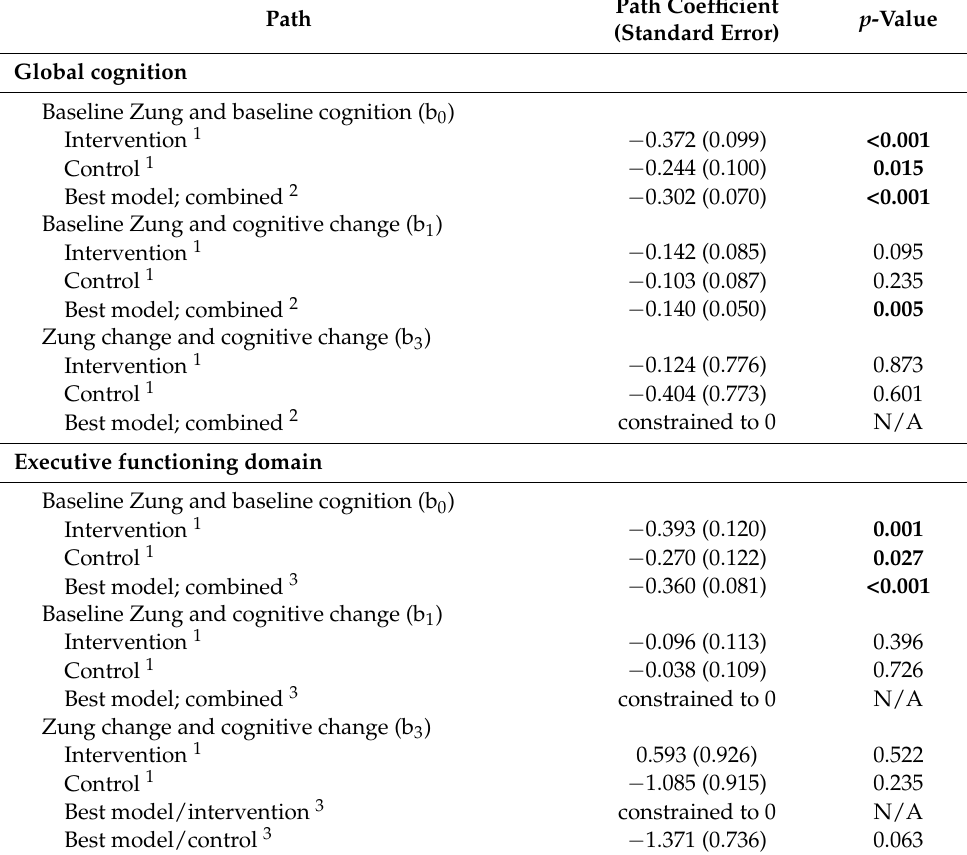
Table 2. Associations between cognition and the Zung depression score during the FINGER trial.